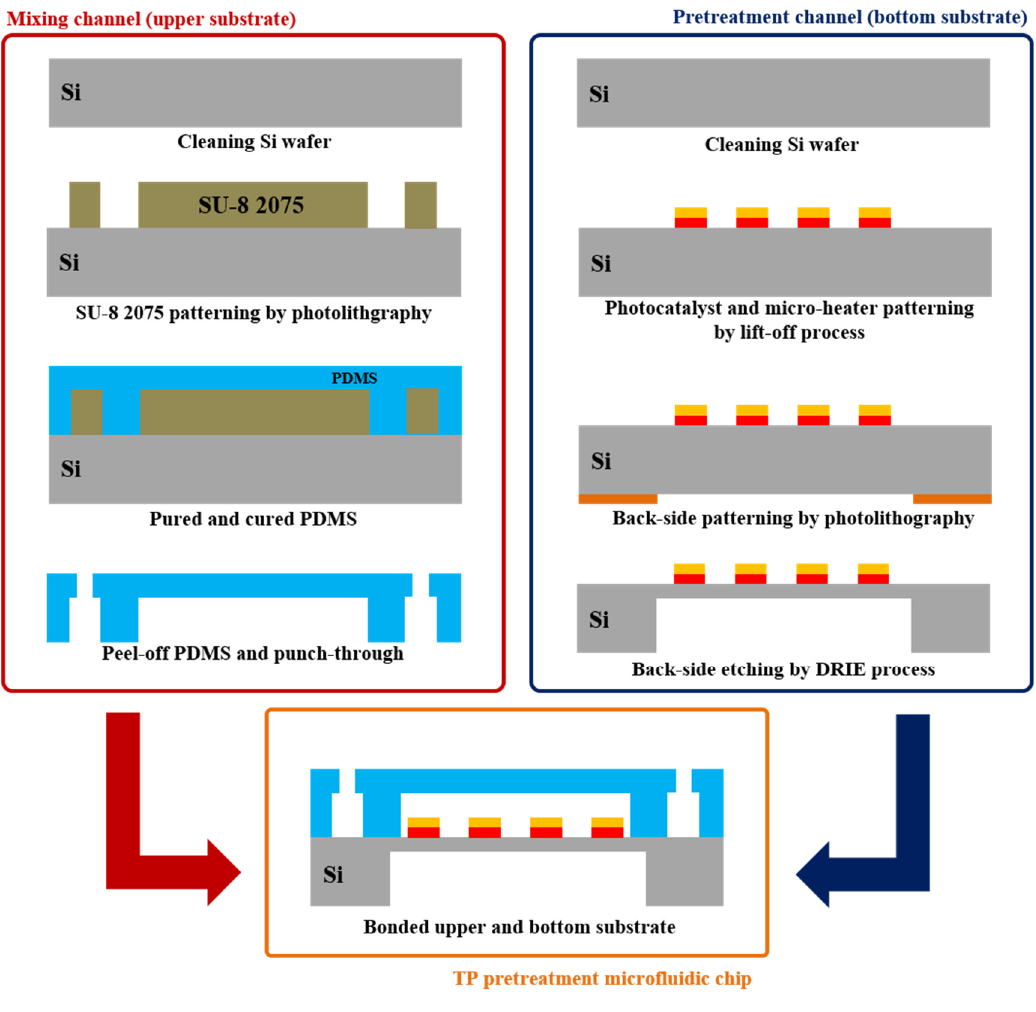
Figure 3. Fabrication process of the proposed TP pretreatment microfluidic chip.